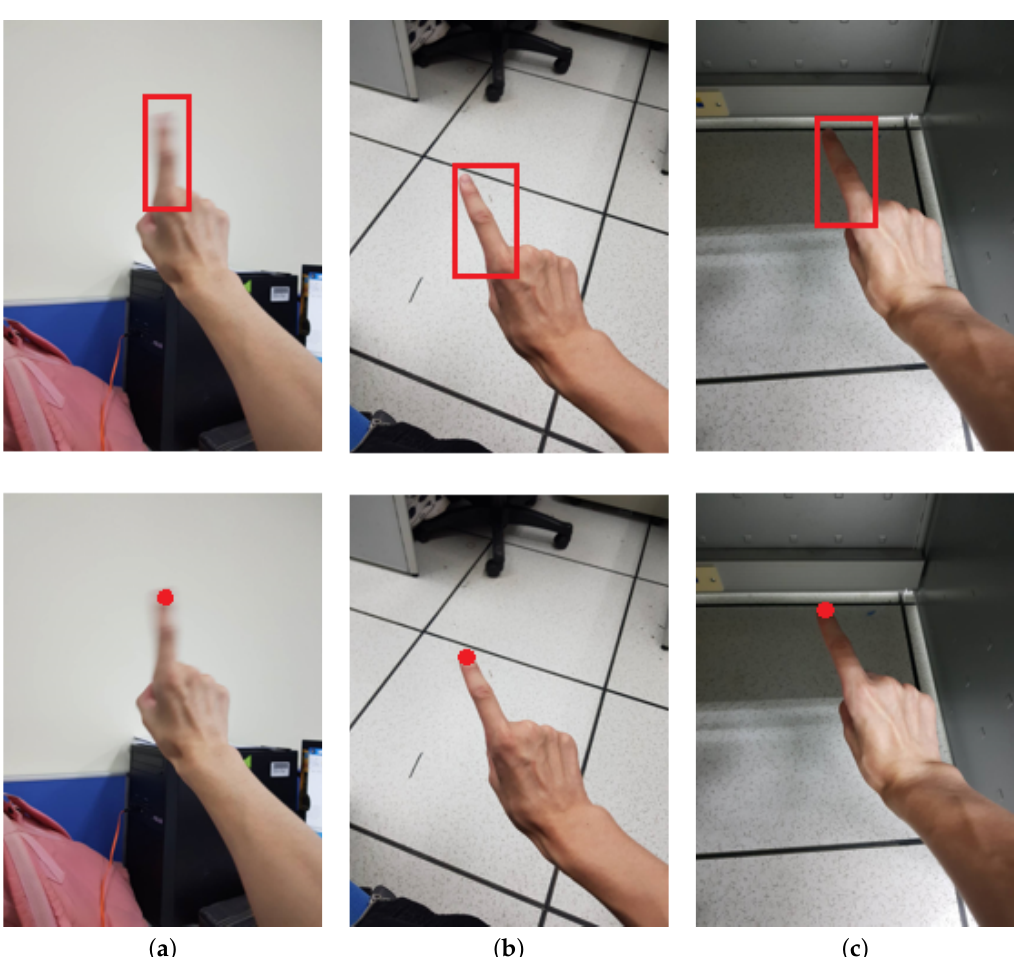
Figure 4. The results of finger and fingertip detection in images of: ( a ) blurred finger; ( b ) lighter scene; and ( c ) darker